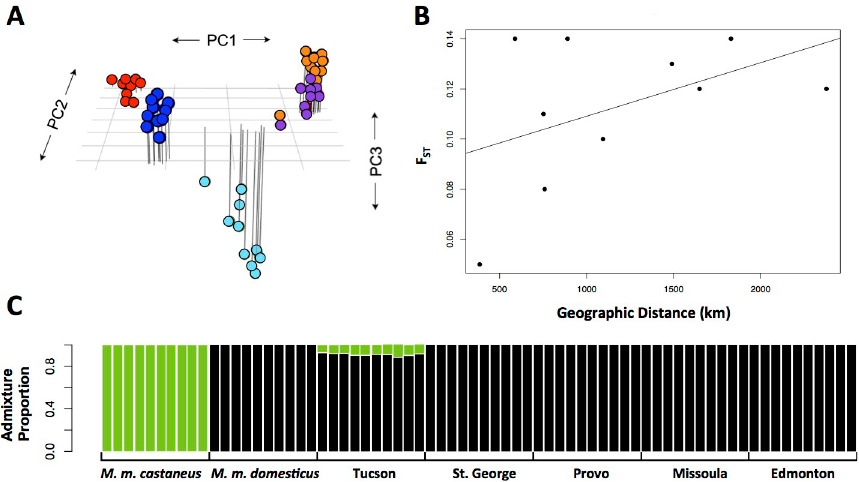
Fig 2. Population structure in mice from the western transect. A) Three dimensional principal components plot of the five western populations from Fig 1: Tucson, AZ (red), St. George, UT (orange), Provo, UT (purple), Missoula, MT (cyran), and Edmonton, AB (dark blue); B) plot of genetic distance as measured by Fst versus geographic distance (km); C) admixture plot of the five western populations with M . m . castaneus ancestry plotted in green and M . m . domesticus ancestry plotted in